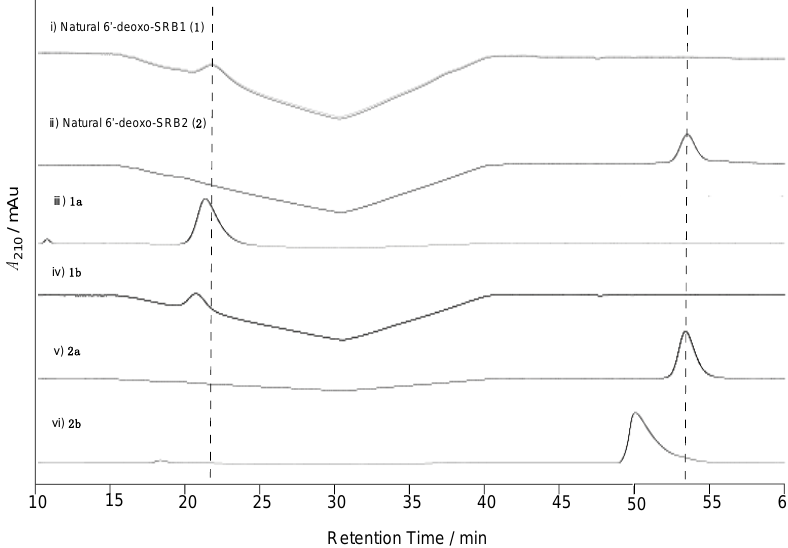
Figure 3. Determination of the C-1’ configuration of natural 6′-deoxo-SRBs ( 1 and 2 ) isolated from KA54. Chiral HPLC analysis of ( i ) natural 6 (cid:48) -deoxo-SRB1 ( 1 ), ( ii ) natural 6 (cid:48) -deoxo-SRB2 ( 2 ), ( iii ) synthetic 1a strain KA54. Chiral HPLC analysis of ( i ) natural 6′-deoxo-SRB1 ( 1 ), ( ii ) natural 6′-deoxo-SRB2 ( 2 ), ( iii ) synthetic 1a , ( iv ) 1b , ( v ) 2a , and ( vi ) 2b . Elution profiles were monitored by UV absorbance at 210 nm.